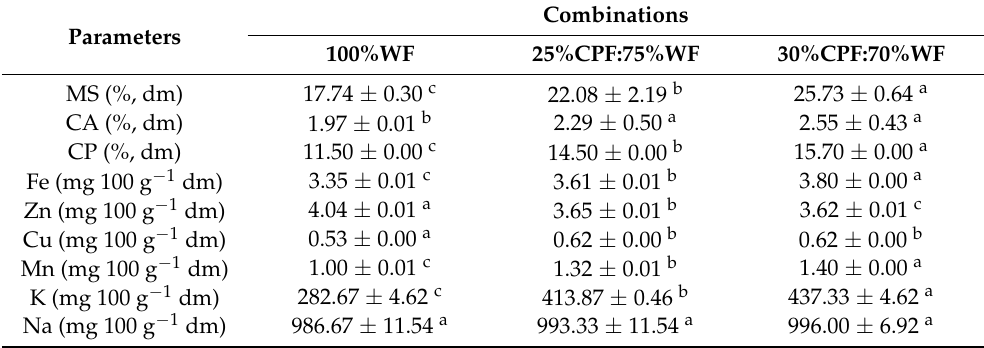
Table 4. Nutritional composition of durum wheat tortilla and fortified durum wheat tortillas.